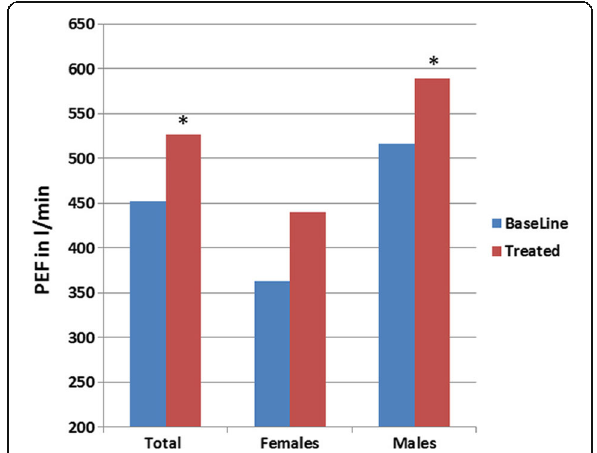
Fig. 4 SC100+ supplement significantly raises mean PEF. SC100+ raised mean total Peak Expiratory Flow (PEF) by 16.6% ( p =0.001 in paired t